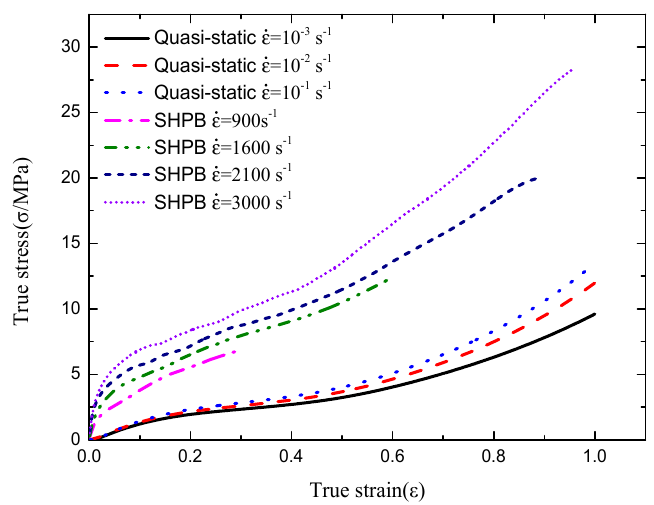
Figure 7. The true stress-strain curves of polyurea at different strain rates.